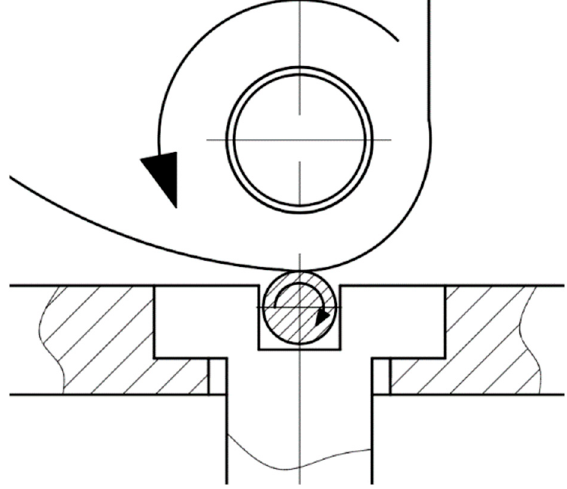
Figure 21. Illustration of the concept of installing a roller in the upper part of the stamp for the purpose of reducing the value of the coefficient of friction µ 2 .